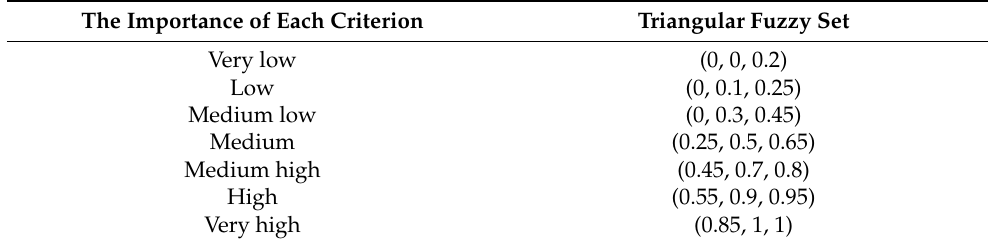
Table 3. Mapping table of language variables and trigonometric fuzzy